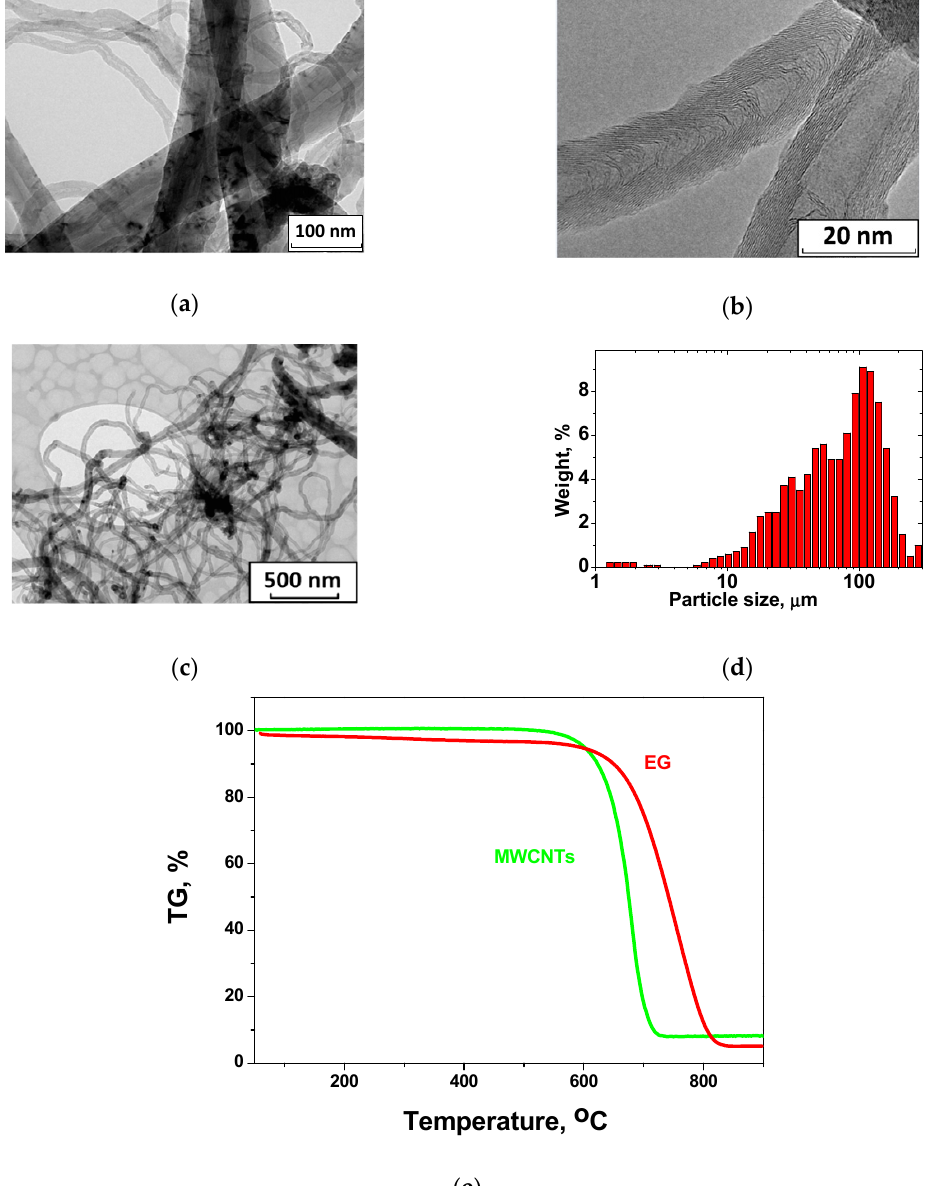
Figure 1. ( a–c ) Transmission electron microscopy (TEM) images of multi-walled carbon nanotubes (MWCNTs); ( d ) particle size weight distribution of MWCNTs; ( e ) thermogravimetric (TG) curves of MWCNTs and expanded graphite (EG).